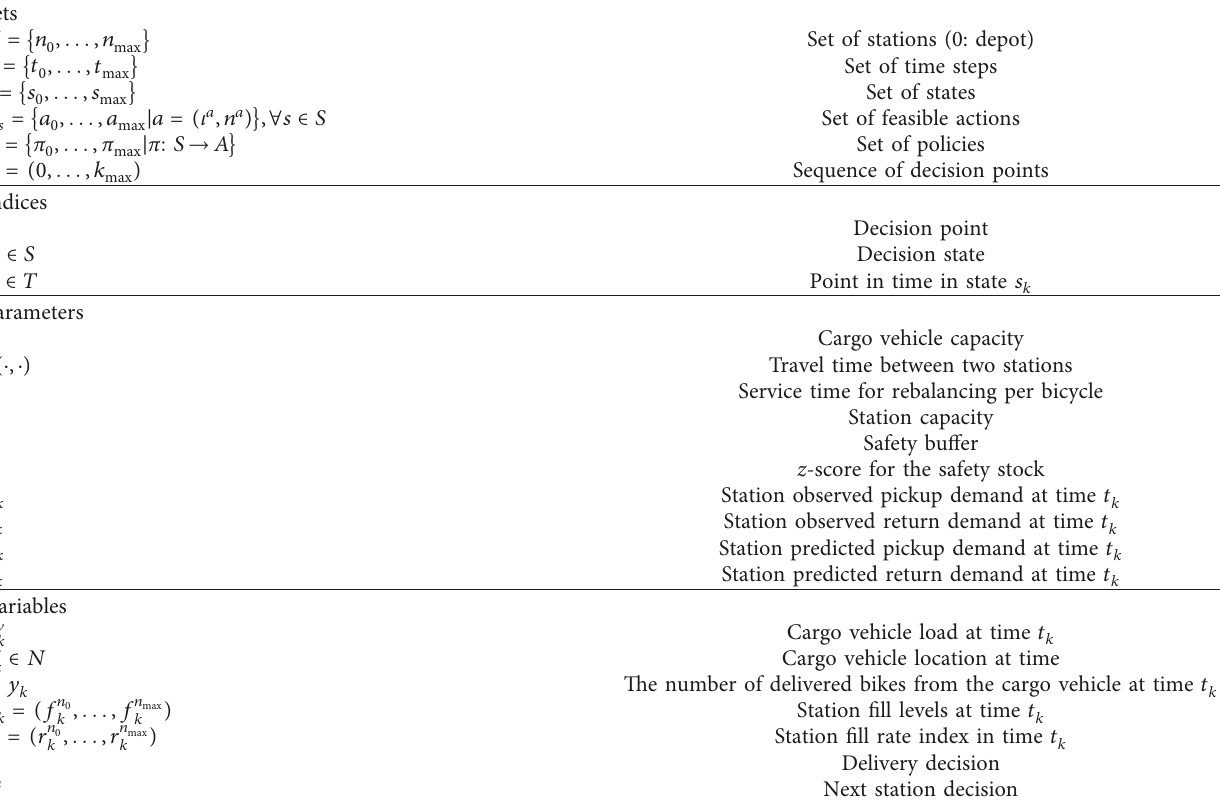
Table 1: The nomenclatures used in this